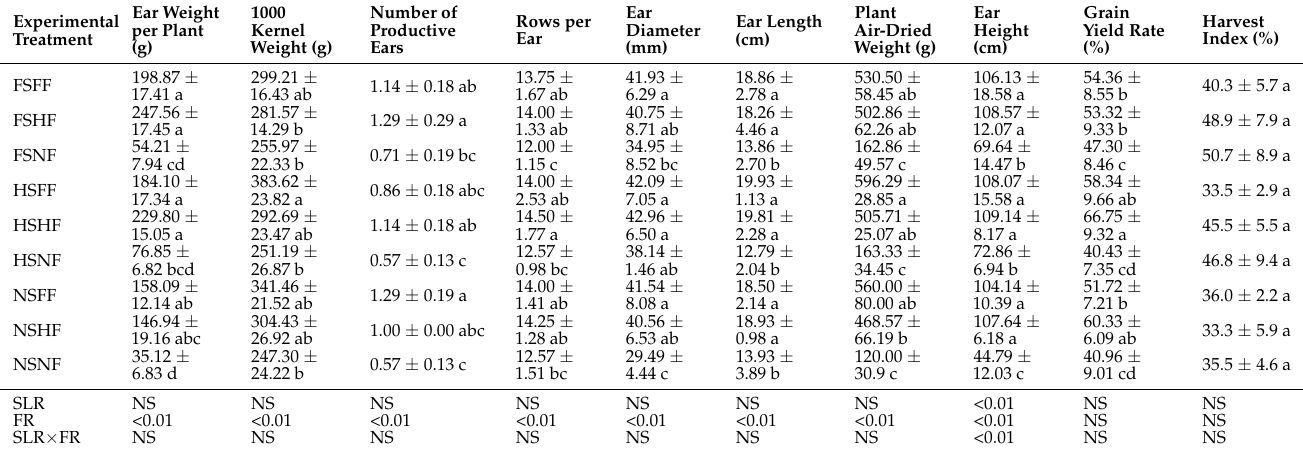
Table 1. Effects of SLR and FR on maize yield component